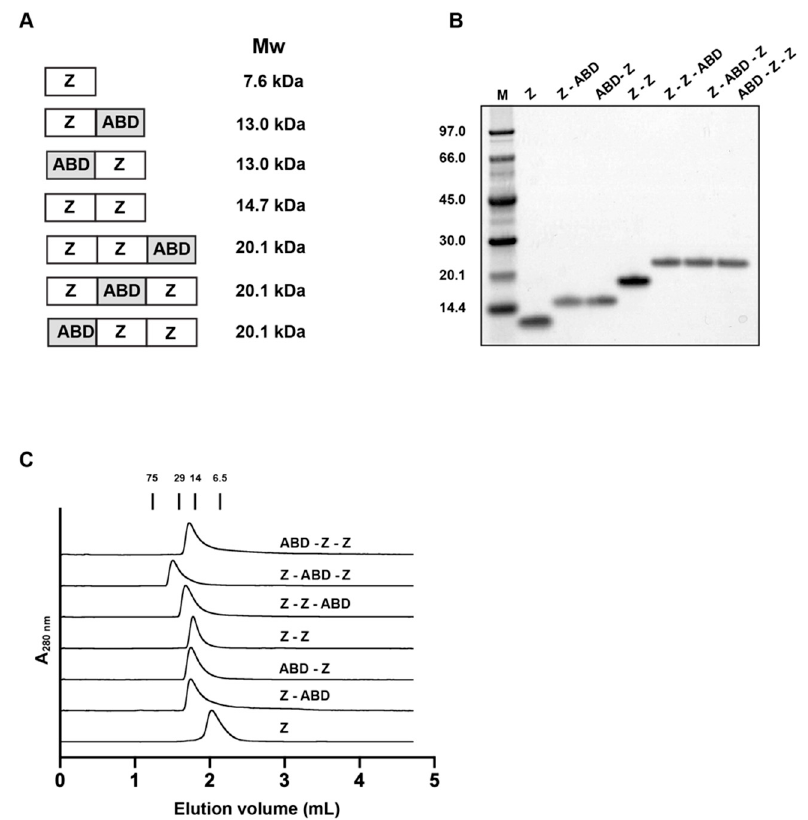
Figure 1. Schematic representation and primary characterization of the seven constructs. ( A ) The composition and theoretical molecular weight of the seven constructs are shown. Z and ABD represent Z HER2:2891 and ABD 035 , respectively. A linker with the amino acid sequence Gly 4 Ser was included between each Z and ABD domain. ( B ) The two-step purified proteins were analyzed by sodium dodecyl sulphate–polyacrylamide gel electrophoresis (SDS-PAGE) under reducing conditions. The numbers to the left of the gel correspond to the molecular weight (in kDa) of the marker proteins loaded in lane M. ( C ) The chromatograms from the size exclusion chromatography analyses are shown. The numbers above the chromatograms correspond to the elution volume of marker proteins with the indicated molecular weights (in